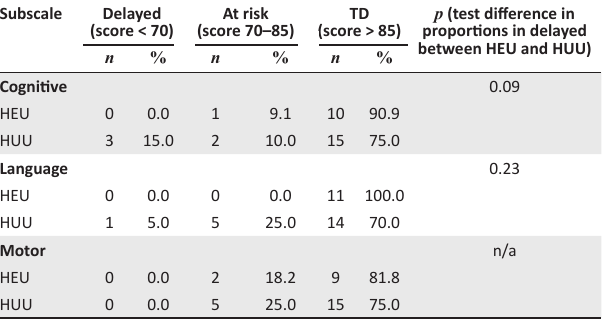
TABLE 5: Proportion of infants delayed or at risk for delay – Neonatal jaundice.